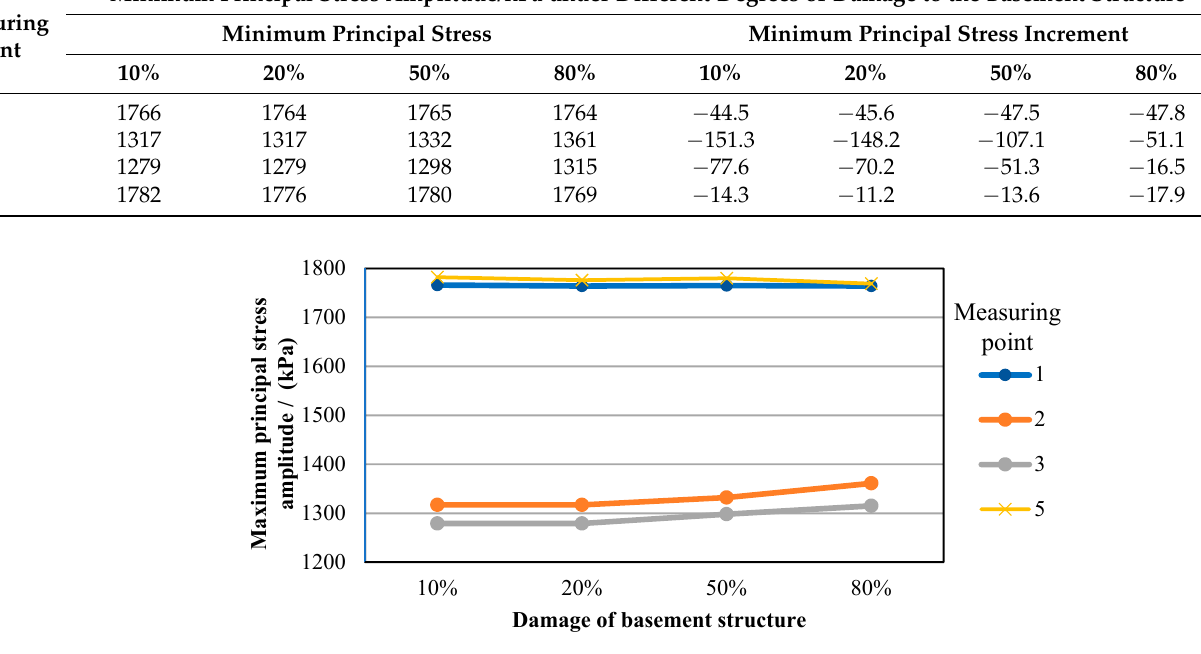
Figure 22. Minimum principal stress amplitude diagram of measuring points 1, 2, 3, and 5 under different degrees of damage to the basement structure.